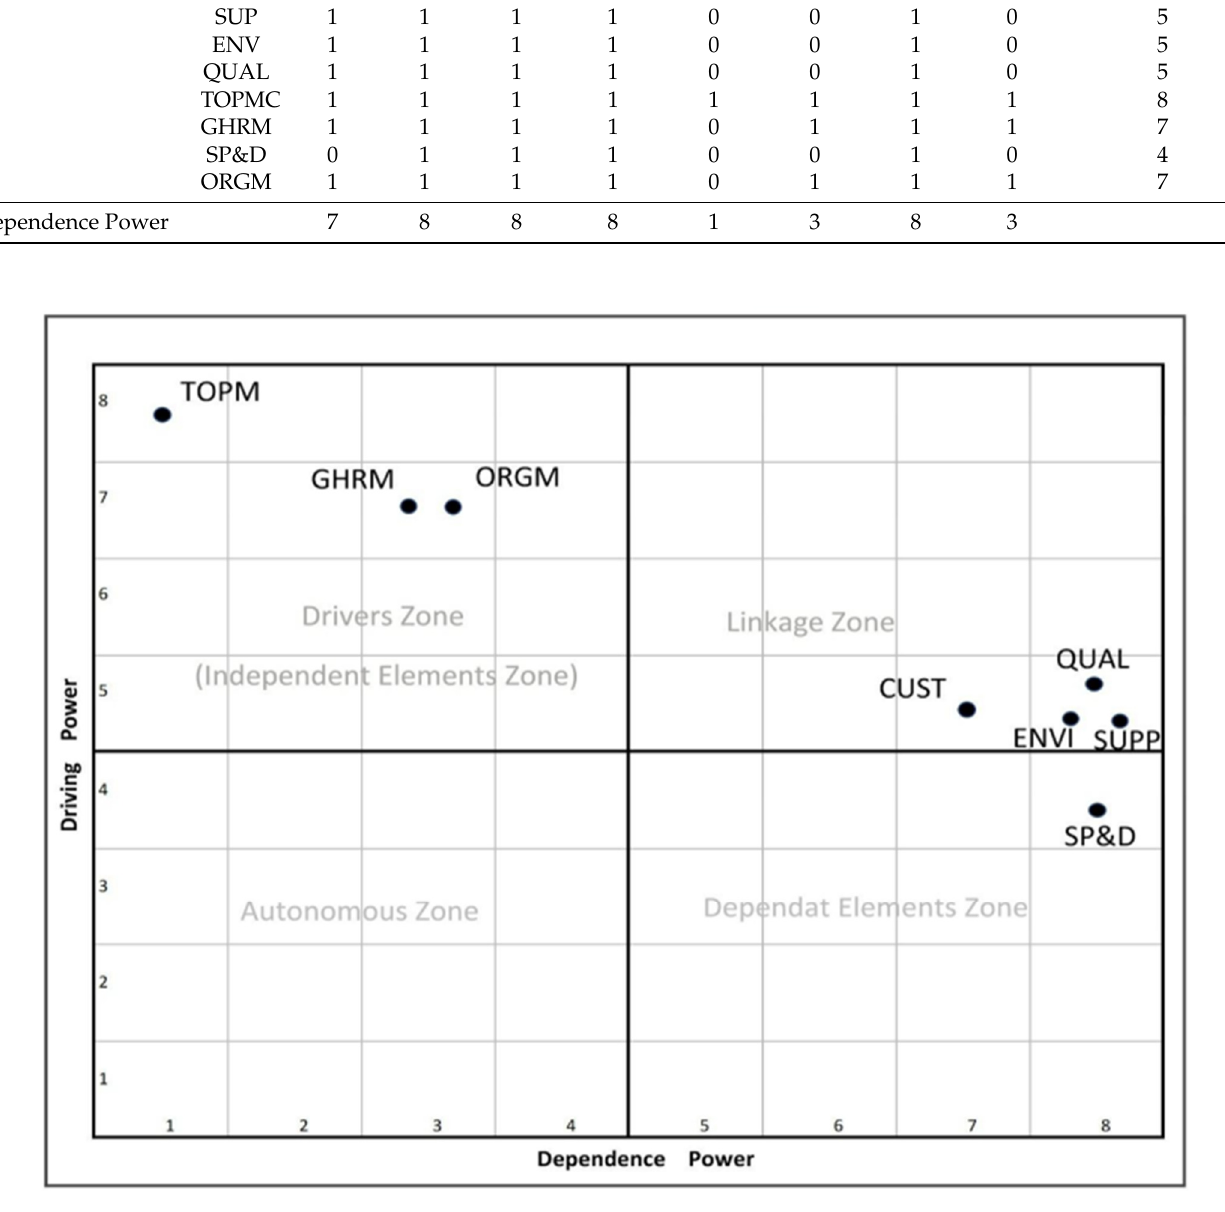
Figure 5. Location of green supply chain management (GSCM) practices in four zones.